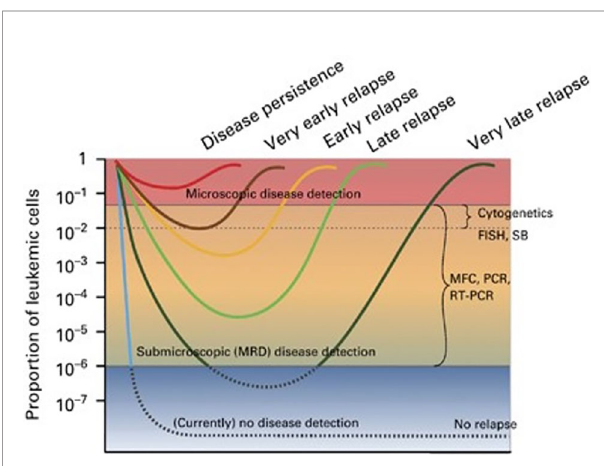
FIGURE 1 | The concept of MRD. Hypothetical scenarios of leukemia cell burden changes in response to therapy (8). Figure from Buckley SA, et al. BMT 2013